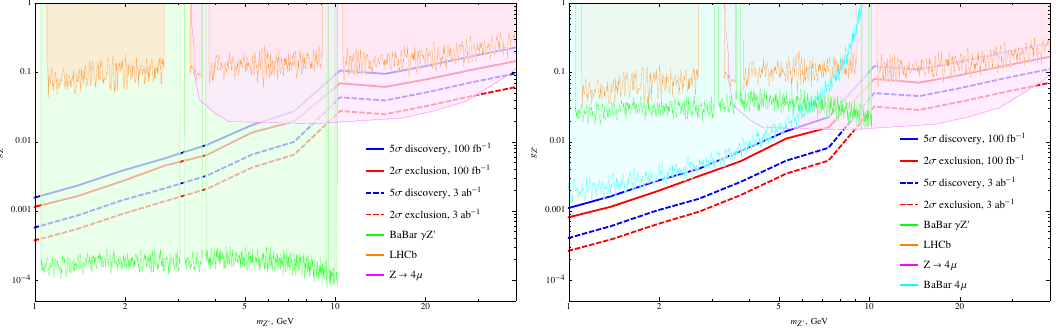
Figure 4 . Exclusion (2 (cid:27) ) and discovery (5 (cid:27) ) contours for the ‘‘(cid:13) searches described in the text. The lepton number model of section 2 is assumed, with A Z 0 BB = (cid:0)A Z 0 WW = (cid:0) N g = 2. The shaded regions indicate the (suggested) bounds from other experiments. The picture on the left hand side concerns with the lepton number theories, that couple indiscriminatingly to all the lepton generations. The picture on the RH side shows the situation, assuming that the Z 0 couples only to the second and the third generations of the leptons ( (cid:22) + (cid:28)